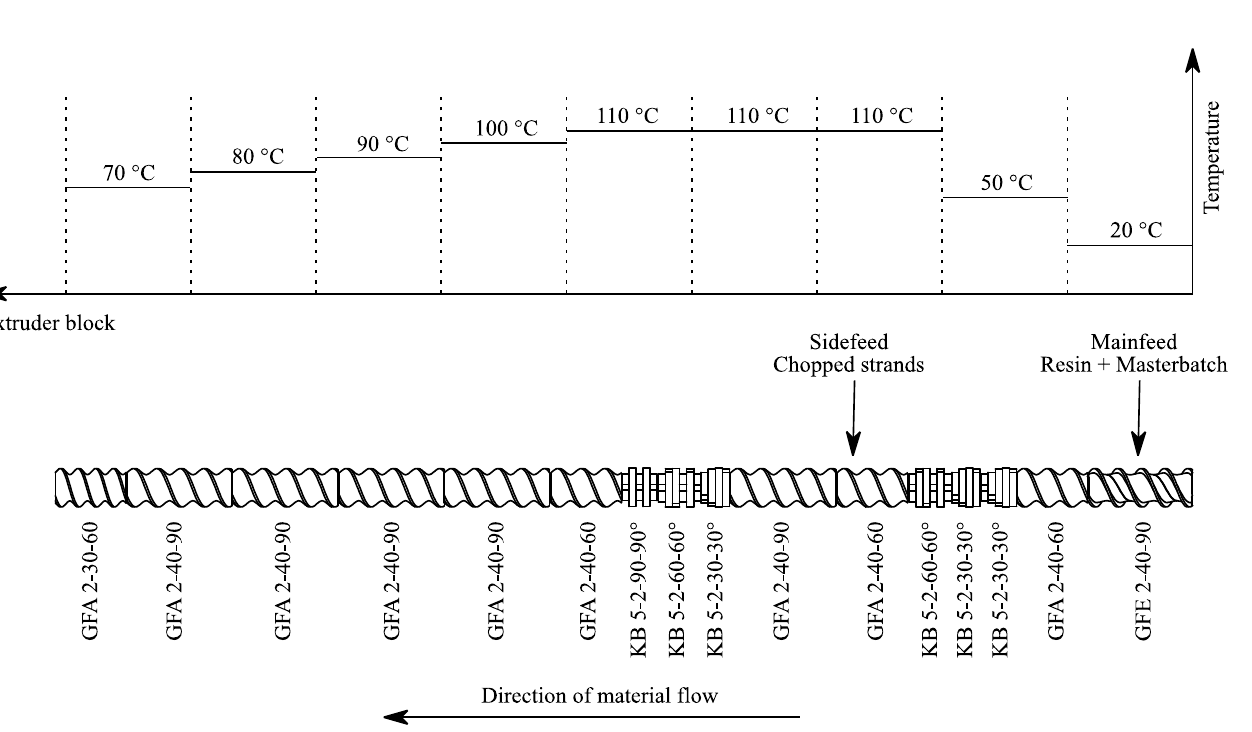
Figure 3. Screw layout and temperature profile for manufacturing the short fiber phenolic molding compounds.